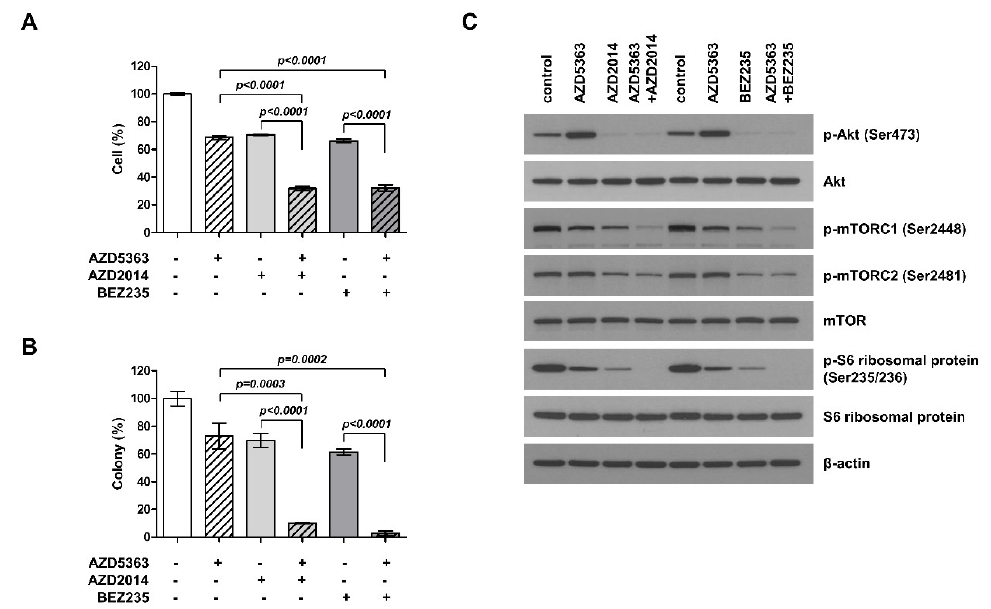
Figure 3. E ff ects of the combination of an AKT inhibitor (AZD5363) and mTOR inhibitors (AZD2014 and BEZ235) on the proliferation of PI3KCA and mTOR-mutated bladder cancer cells. ( A ) The combination therapy with AZD5363 (3 µ M) and mTOR inhibitors (1 µ M AZD2014 and 0.5 µ M BEZ235) exerted synergistic inhibitory e ff ects on the growth of J82 cells. ( B ) The e ff ects of the combination therapy on J82 cells were determined using the colony formation assay. ( C ) The e ff ects of the combination therapy on PI3K / AKT / mTOR signaling pathway in J82 cells were detected by Western blot analysis. Cells were treated with drugs for 24